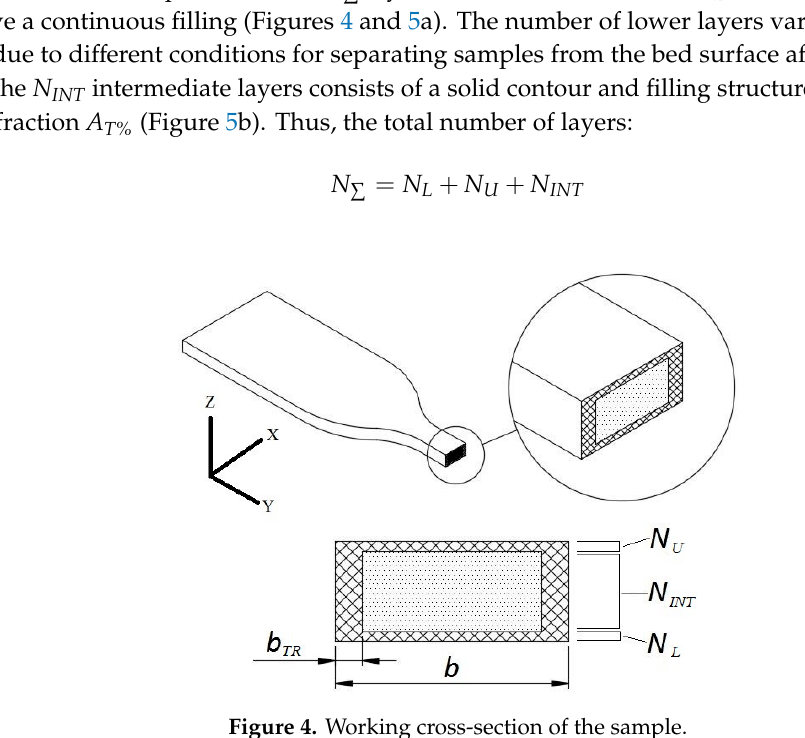
Figure 4. Working cross-section of the sample.